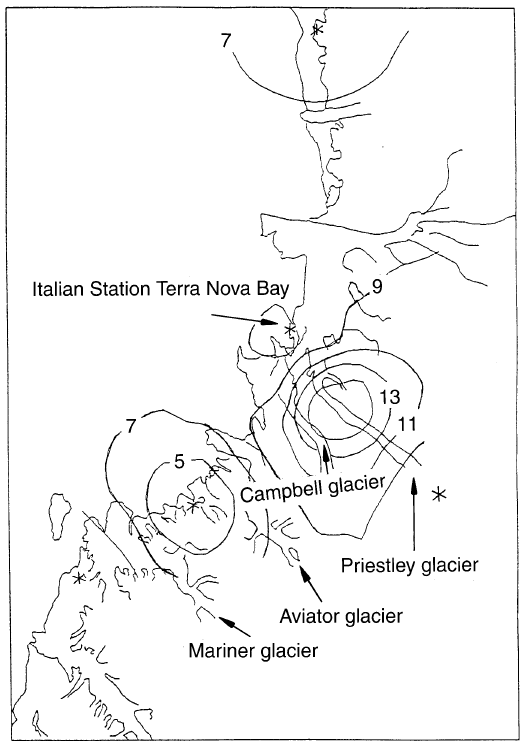
Fig. 5. Monthly average wind speed isolines (m/s), August